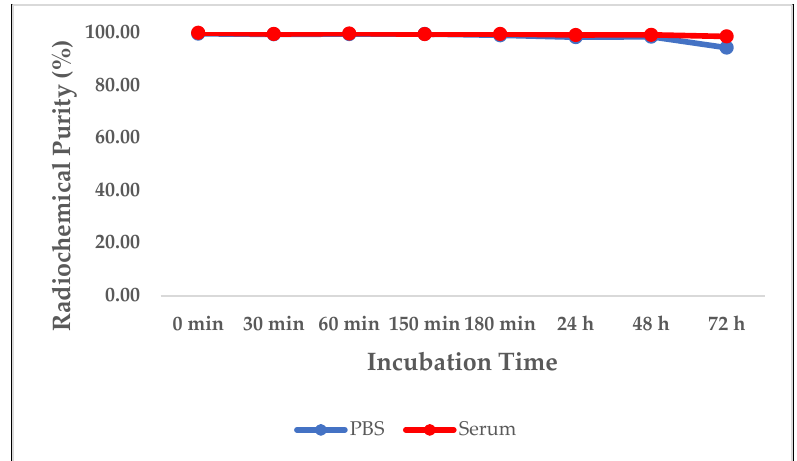
Figure 5. Radiolabeling stability of [ 131 I]-IgY anti-RBD spike SARS-CoV-2 in PBS and human serum over 72 h.